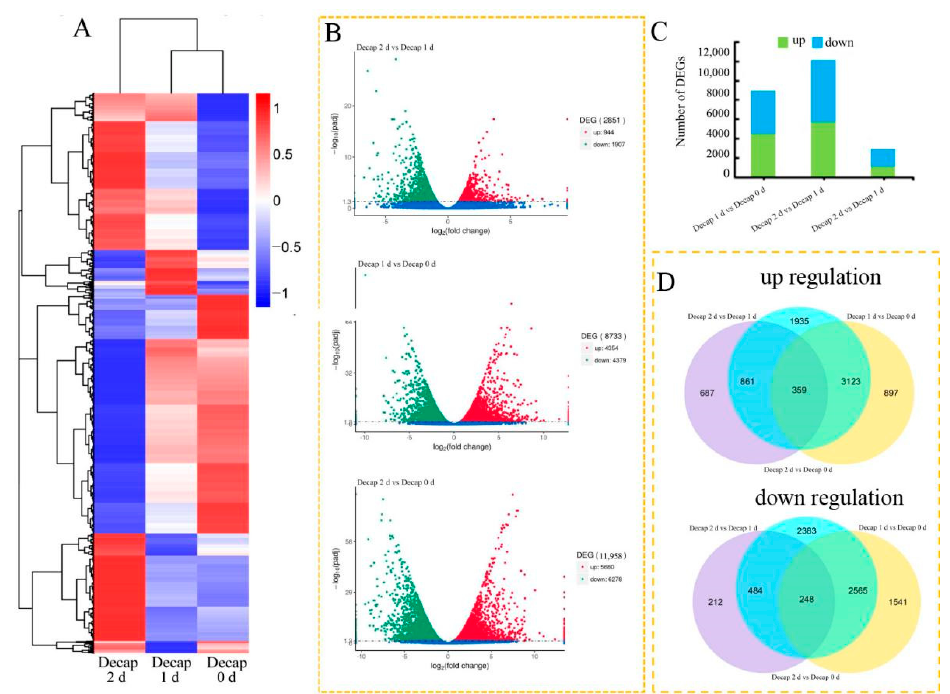
Figure 3. Transcriptional variations in sunflower buds after decapitation. ( A ) A heatmap shows the expression profiles of the DEGs under different treatments. ( B ) Analysis of the significance of the DEGs in various comparisons using volcano plots. ( C ) The number of genes that were up-and down-regulated in the various comparisons. ( D ) Venn diagrams illustrating the proportions of up-and down-regulated genes in three contrasts.